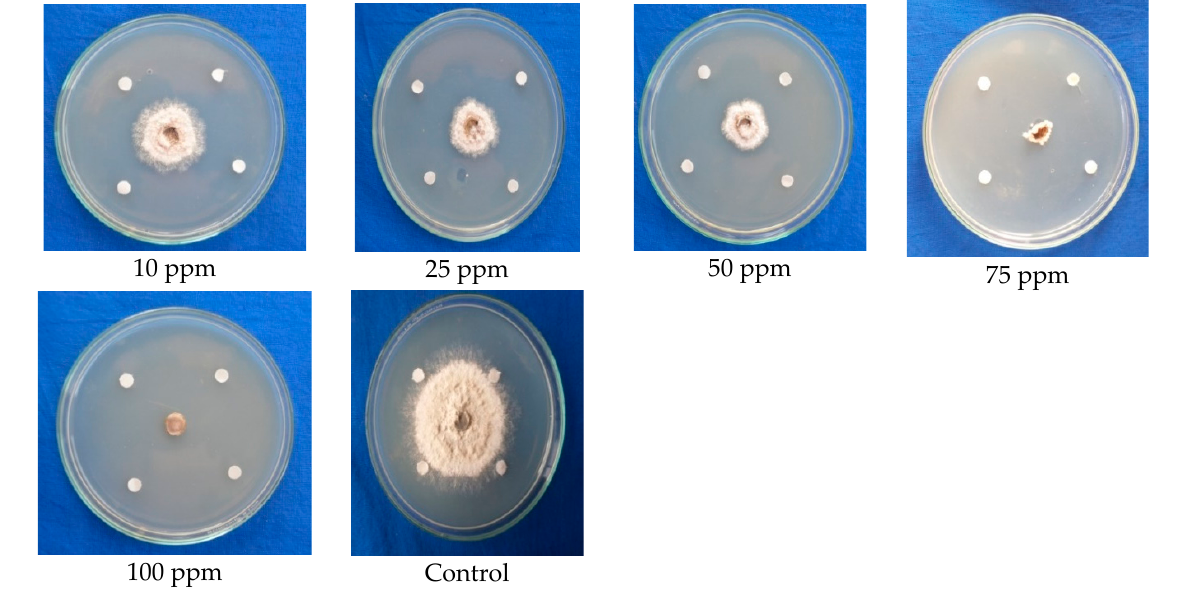
Figure 6. Confirmation of the antifungal efficacy of benzothiazole at different concentrations against mycelial growth of C. gloeosporioides (paper disc assay). Table 5. Testing the antifungal efficacy of different concentrations of benzothiazole against mycelial growth C. gloeosporioides by paper disc assay.